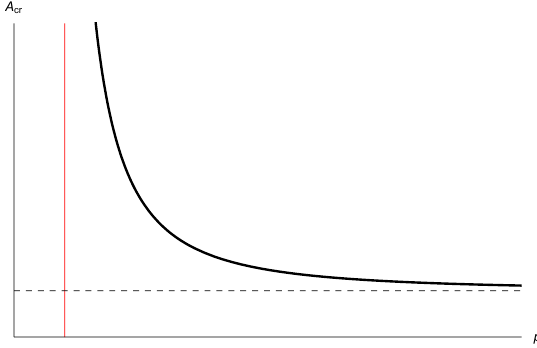
Figure 5 . The critical curve of q -Yang-Mills theory, in terms of the parameter A = λ/p as a function of p . The horizontal asymptote (dashed) is the DK critical point A cr = π 2 . The vertical asymptote (red) is the point p = 2 . This plot is inspired by